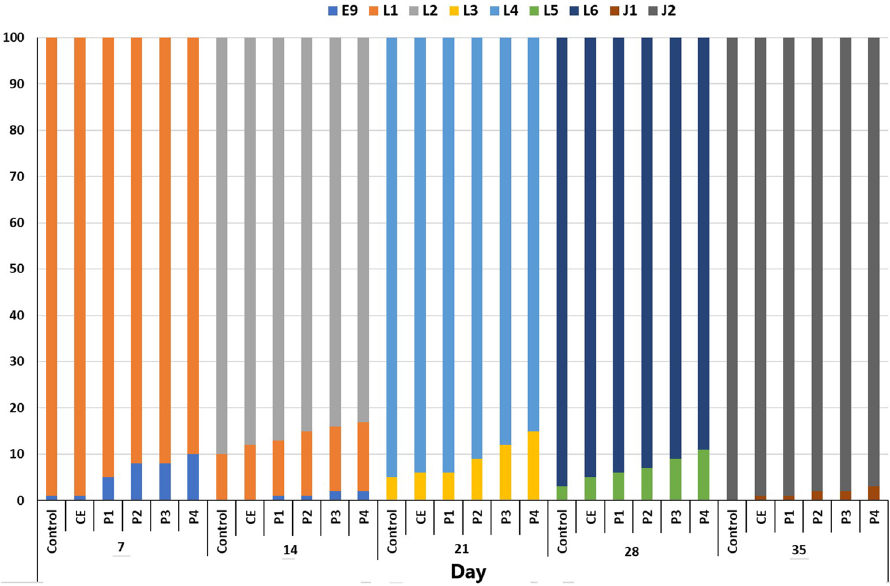
Figure 1. Developing stages of common carp ( Cyprinus carpio ) during 35 days of exposure to praziquantel. E embryonic stage, L larval stage, J juvenile stage.